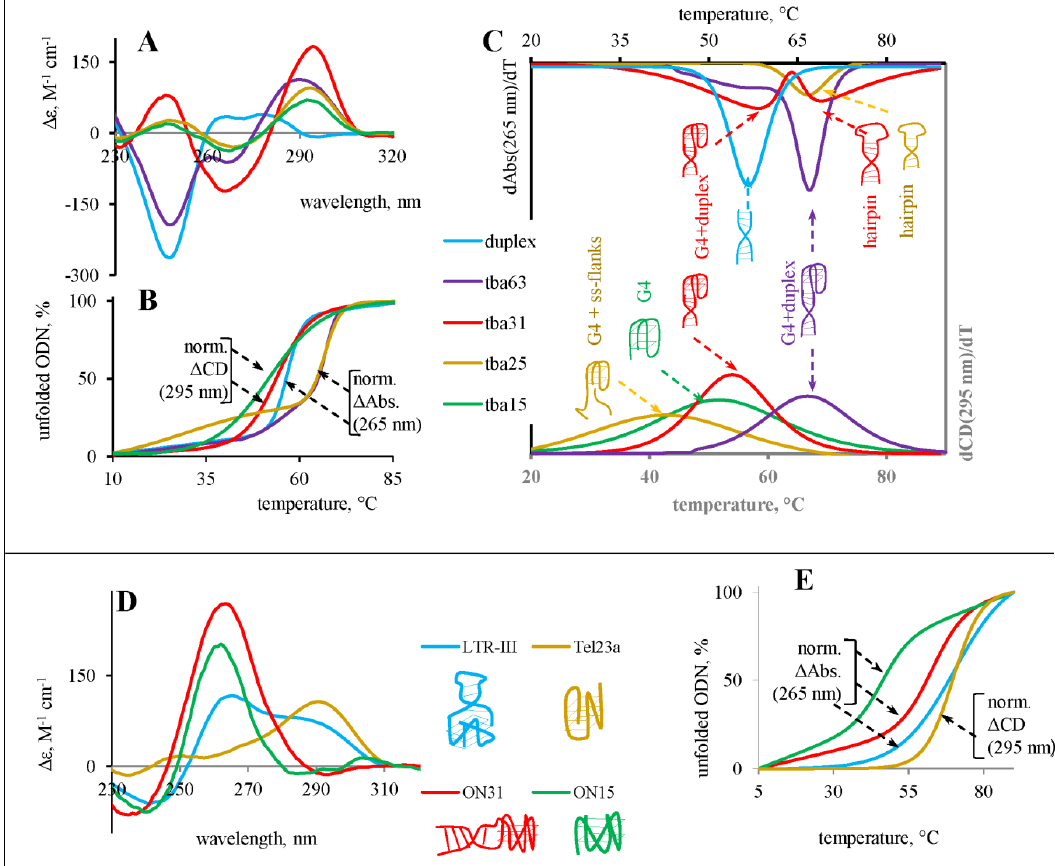
Figure 2. Secondary structures of the ONs: CD spectra and melting curves. ( A ) CD spectra of the deoxy-TBA ONs. ( B ) Melting curves of the deoxy-TBA ONs. ( C ) First derivatives of the deoxy-TBA melting curves and schematic representations of the ON secondary structures. ( A – C ) have a joint legend. ( D ) CD spectra of the ribo-ONs (ON31 and ON15), LTR-III and Tel23a and schematic representations of the possible ON secondary structures. ( E ) Melting curves of the ribo-ONs, LTR-III and Tel23a. ( D ) and ( E ) also have a joint legend. CD spectra were recorded at 5 ◦ C. ON concentrations were 2.5 uM (TBA63, TBA31, and ON31), 3.5 uM (TBA25 and LTR-III), or 5 uM (TBA15, Tel23a, and ON15). ∆ CD / Abs changes were normalized (divided by ∆ max.) to calculate unfolded ON